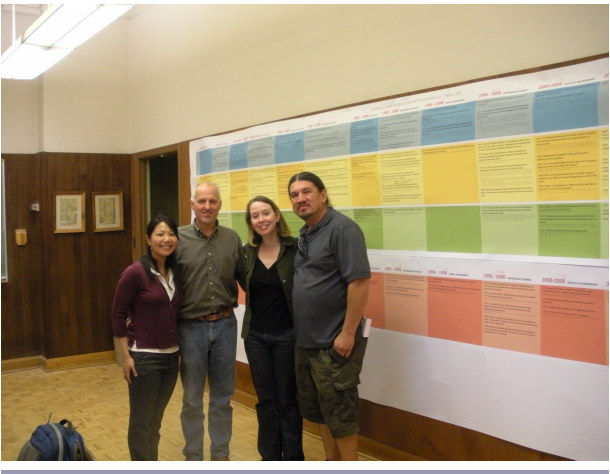
Fig. 1. Ron Reed and Sibyl Diver with Karuk Tribe–UC Berkeley Collaborative members Tom Carlson and Lichia Liu. First draft of the Karuk Lands Management Historical Timeline is in the background. See https://karuktimeline.